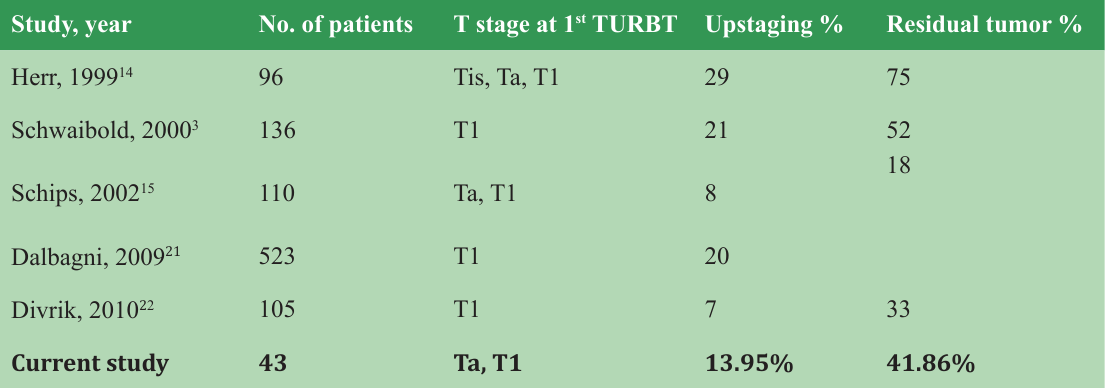
Table 5: Studies on rate of residual tumor and upstaging after second TURBT Study,